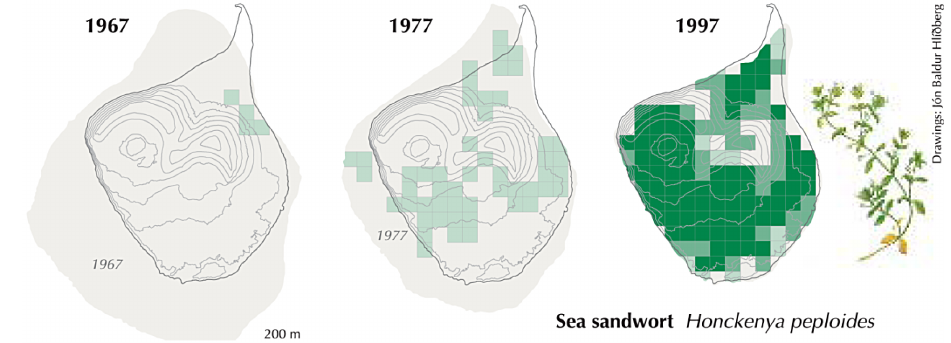
Figure 2. During 1967 to 1997 Honckenya peploides dispersed to every part of Surtsey. The shaded areas indicate the shape of the island in the respective years. The intensity of green reflects the abundance of the plant (Jakobsson et al., 2007). Reproductive response of Honckenya peploides to colonization of Surtsey